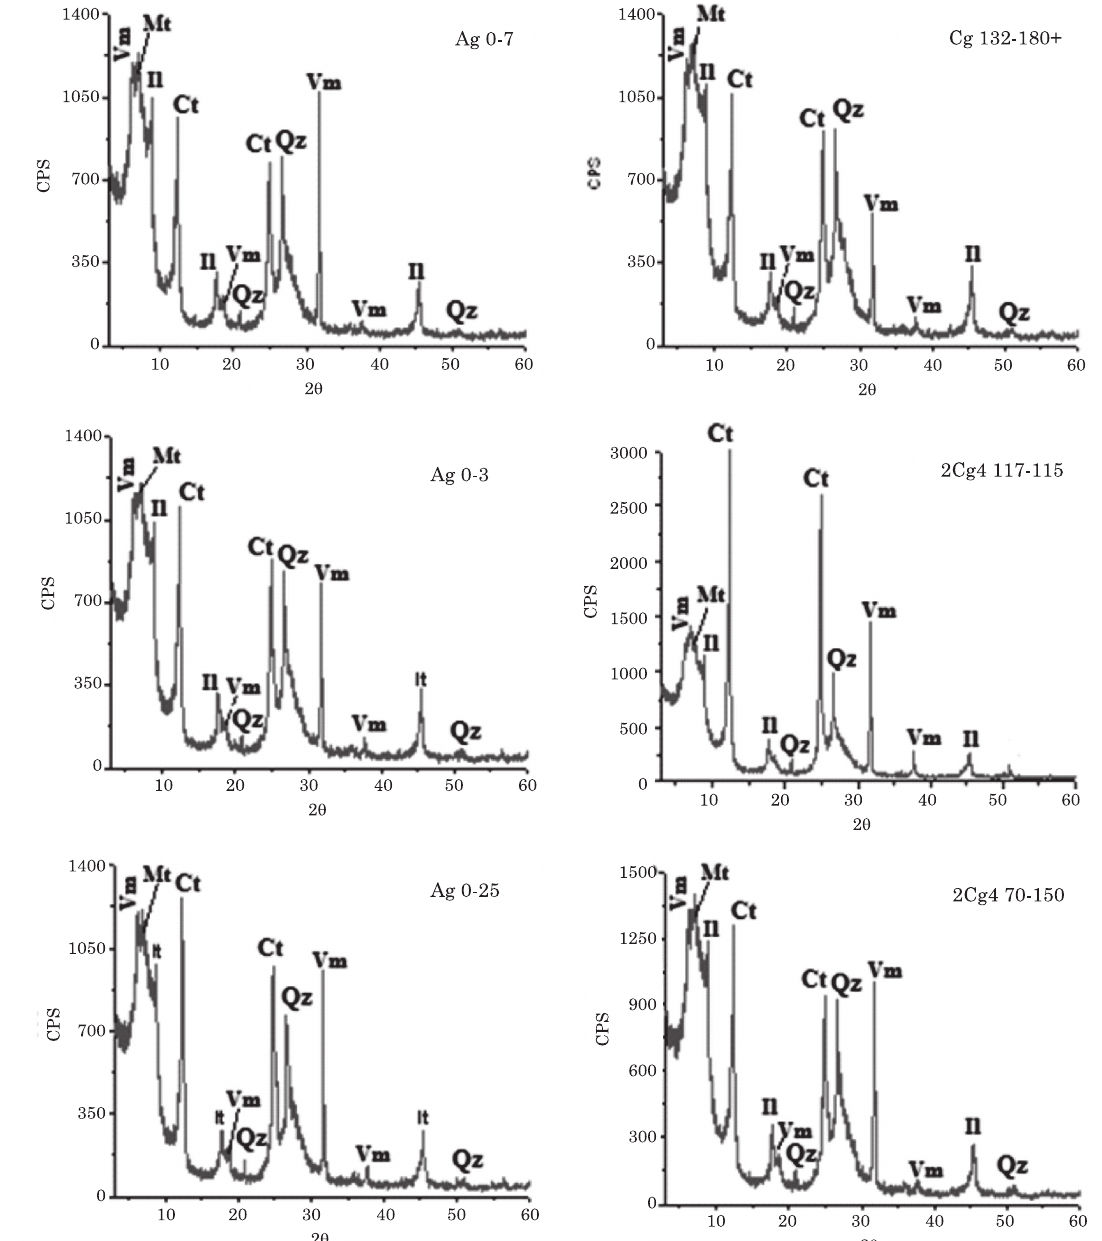
Figura 2. Difratogramas de raios-X da fração argila desferrificada de Gleissolos da várzea do rio Solimões, AM: CAL-3: Caldeirão (Cg 1 0-7; Cg 5 132-180 + ); CAL-4: Caldeirão (Ag 0-3; 2Cg 4 117-155); CAL-5: Caldeirão (Cg 1 0-25; Cg 4 70-150). Vm: vermiculita; Mt: montmorilonita; Il: ilita; Ct: caulinita; e Qz: